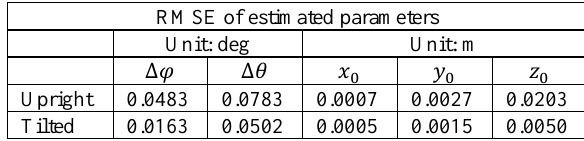
Table 2. RMSE of estimated intrinsic parameters of two